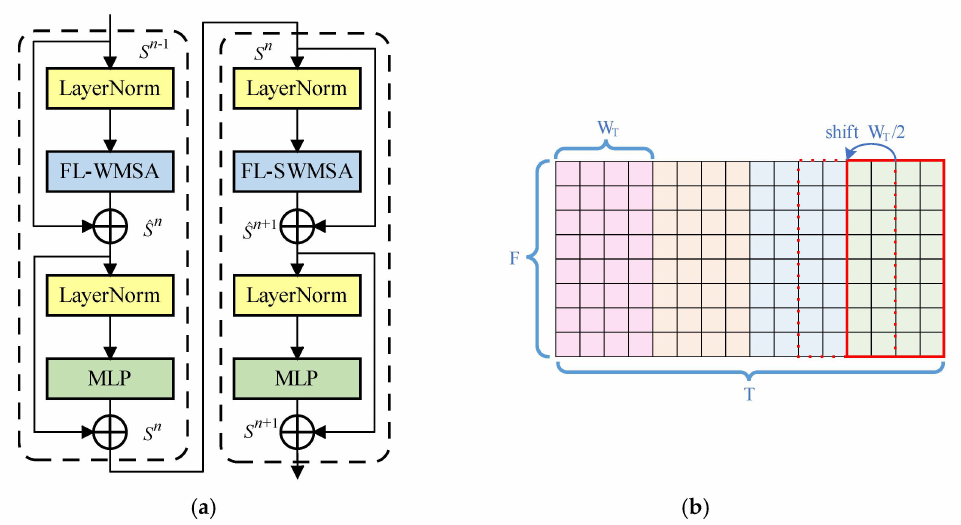
Figure 3. ( a ) The structure of a frame-level Swin Transformer layer. ( b ) The illustration of the window self-attention mechanism of a frame-level Swin